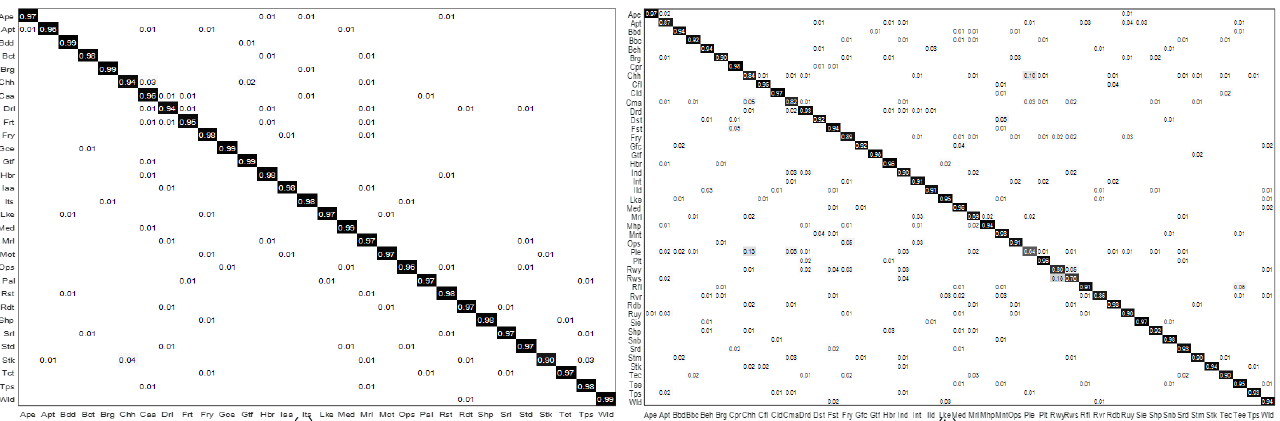
Figure 13. Confusion matrix, ( a ) represents our proposed method, ( b ) represents the LGRIN